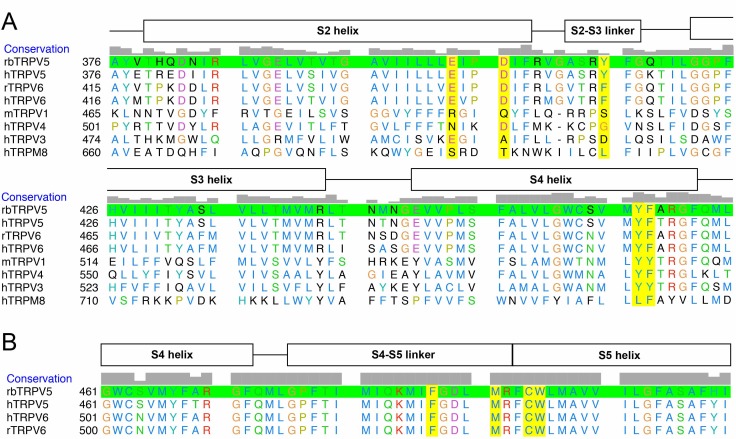
Select sequence alignments.(A) Sequence alignments for the S1-S4 bundle for various TRP family channels. rbTRPV5 is highlighted in green. (B) Sequence alignments for the S4-S5 linker of multiple orthologs of TRPV5 and TRPV6. Residues that constitute the compound binding sites are highlighted in yellow. Sequence conservation is shown above the alignments and represented as gray boxes.